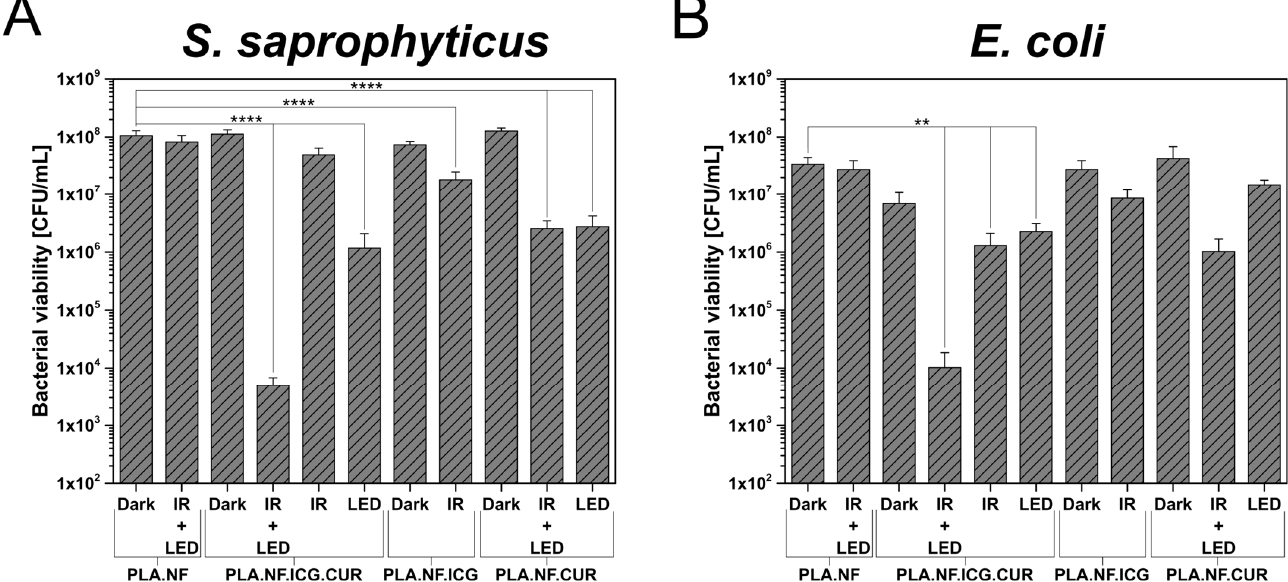
Figure 4. Bacterial viability of Staphylococcus saprophyticus subsp. bovis ( S. saprophyticus ; A ) and Escherichia coli DH5 alpha ( E. coli ; B ) on the different formulations of the produced nanofibers after irradiation with a laser module (IR: 810 nm) and an LED panel (LED: 457 nm) for 30 min each. Unloaded fibers (PLA.NF) were used as the negative control and dark represents unirradiated bacteria. Probability values of p < 0.05 were considered significant. Statistical differences are denoted as “**” p < 0.01 and “****” p < 0.0001.